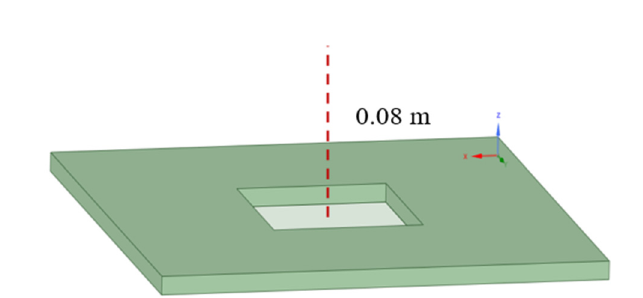
Figure 11. Comparison of dimensionless wind velocity along the analysis line (H: height above the ground, Hmax: reference height for the wind velocity, U: wind velocity, Uref: wind velocity at the height of Hmax [27]).